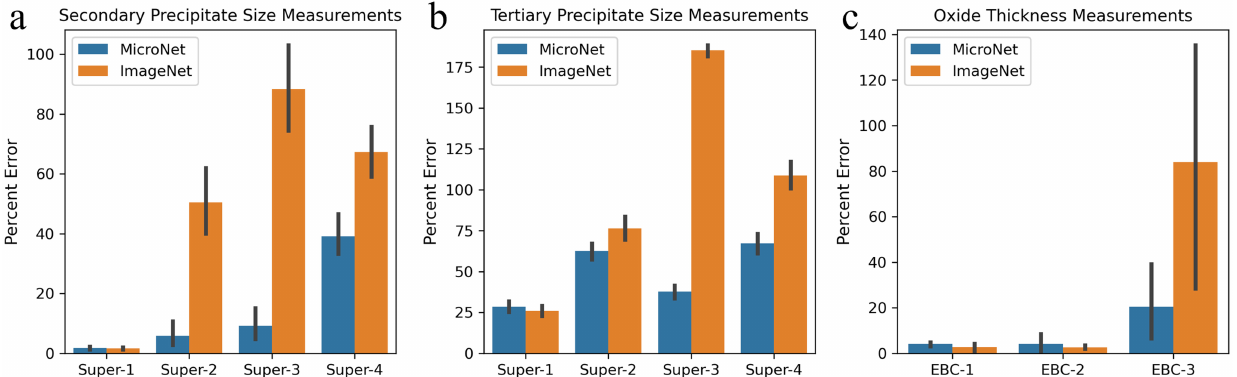
Fig. 6 Plots showing percent error in size measurements performed on segmented images. a compares the average percent measurement error when measuring the size of individual secondary precipitates from test set images segmented by the best models in the Super experiments. Error bars are the standard deviation of the error across all the precipitates in the test set images. b compares the error of tertiary precipitate size measurements. c compares the average percent error of thermally grown oxide thickness measurements after performing simple morphology operations on the segmented test images. The error bars are the standard deviation across the three test Fig. 6c. Measurement errors using models trained EBC-1 and EBC-2 MicroNet model was highly useable for oxide thickness measure- were less than 5% for both MicroNet and ImageNet with ImageNet ments after simple morphological operations (such as binary performing slightly better. For the one-shot case (EBC-3) MicroNet opening which is useful for removing small objects to remove the segmented the oxide with enough accuracy to obtain an average noise in the segmentation mask). The error of oxide thickness measurement error of 20% while the ImageNet model produced measurements made on the segmented images is shown in